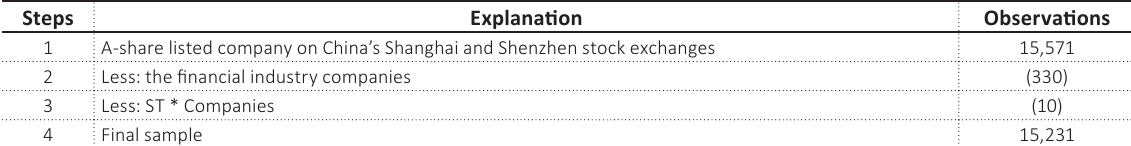
Table 2. Sample selection process